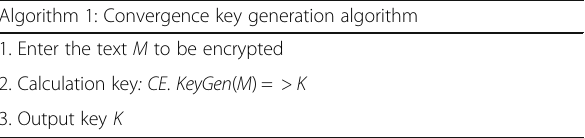
Algorithm 3: Decryption